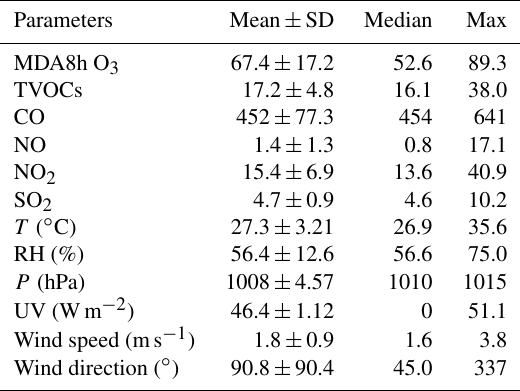
Figure 1. Time series of major trace gases, photolysis rate constants, and meteorological parameters during 20–29 Septem- ber 2019 in Xiamen. Table 2. Descriptive statistics of major trace gases (ppbv) and me- teorological parameters during 20–29 September